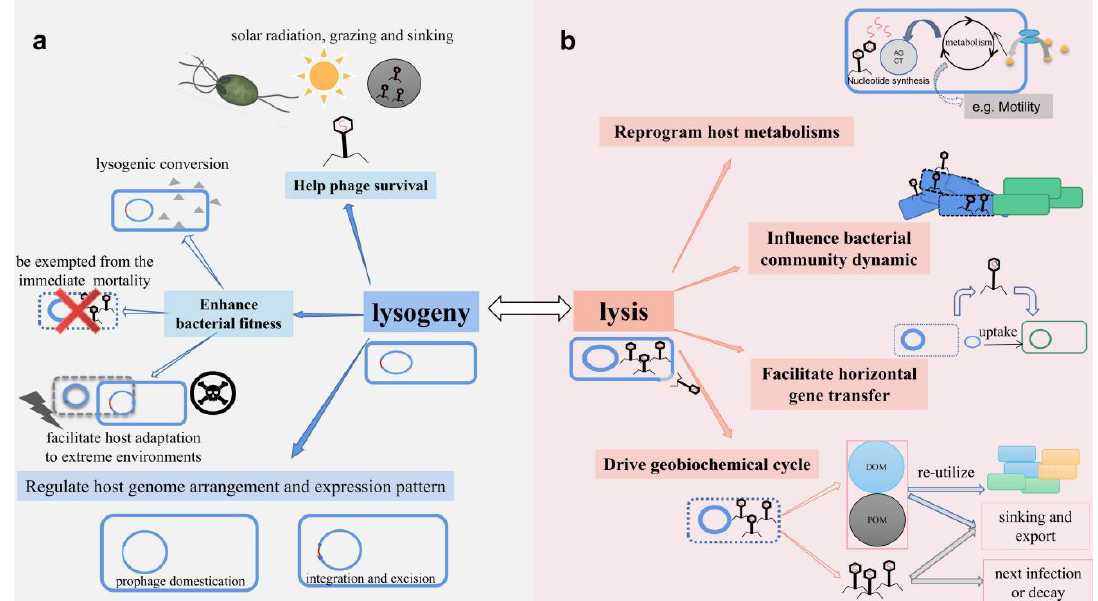
Figure 2. Potential ecological implications of lysogenic/lytic transition. ( a ) Potential ecological implications of lytic to lysogenic cycle transition. The transition protects free phages from various stresses such as solar radiation, grazing, and sinking by attaching to marine aggregates. Lysogeny also enhances bacterial fitness through lysogeny conversion, which averts immediate mortality and facilitates host adaptation to extreme environments. Moreover, lysogeny regulates the host’s genome arrangement and expression pattern through integration and excision of prophages. The red cross symbol represents that hosts are exempted from immediate phage-mediated lysis, while the ray and skull symbols represent the harsh environmental conditions. ( b ) Potential ecological implications of lysogenic to lytic cycle transition. Prophages entering the lytic cycle reprogram the host’s metabolism to favor phage replication, influence the bacterial community structure through phage-mediated host mortality, facilitate horizontal gene transfer, and drive the biogeochemical cycle.